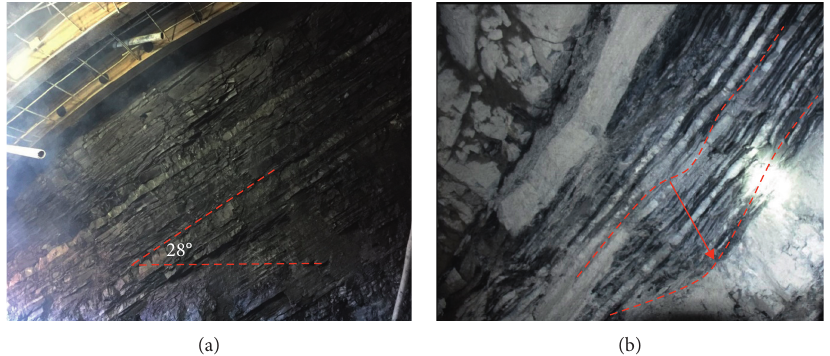
Figure 7: (a) Bedding development. (b) Flexural deformation.